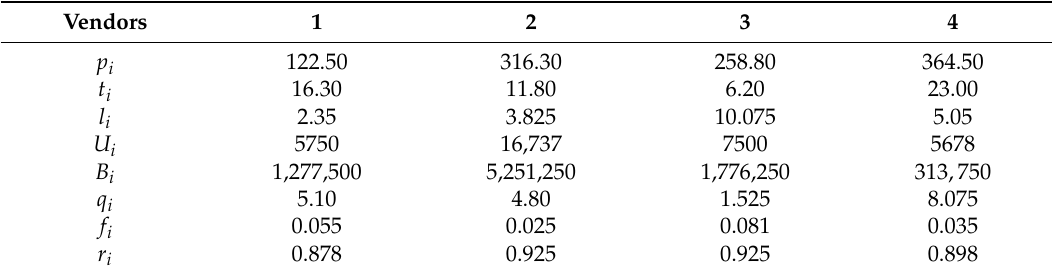
Table 14. Averaging data of Vendor Selection